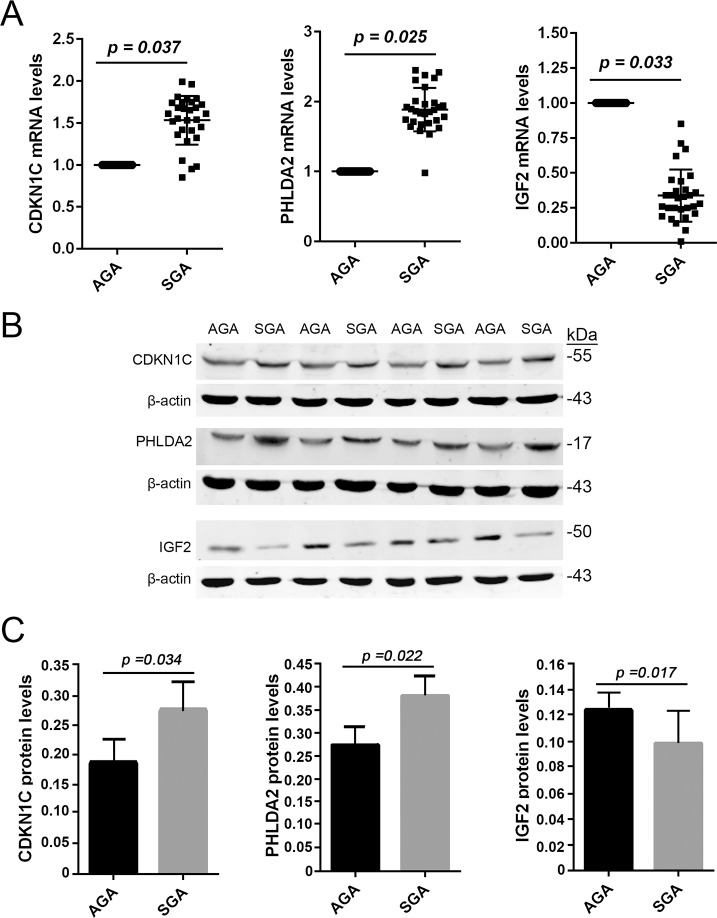
Expression levels of imprinted genes in placenta tissue.The expression levels of imprinted genes in placenta tissue were compared between the SGA and AGA infants. A. Total RNA was extracted from placental tissue, and real time qPCR was performed to measure the mRNA levels of CDKN1C, PHLDA2 and IGF-2. B. Western blot assay was used to evaluate the protein levels of placental CDKN1C, PHLDA2 and IGF-2. Data are presented as mean ± SD. n = 29. *p < 0.05, SGA vs AGA. SGA: small for gestational age. AGA: appropriate for gestational age.